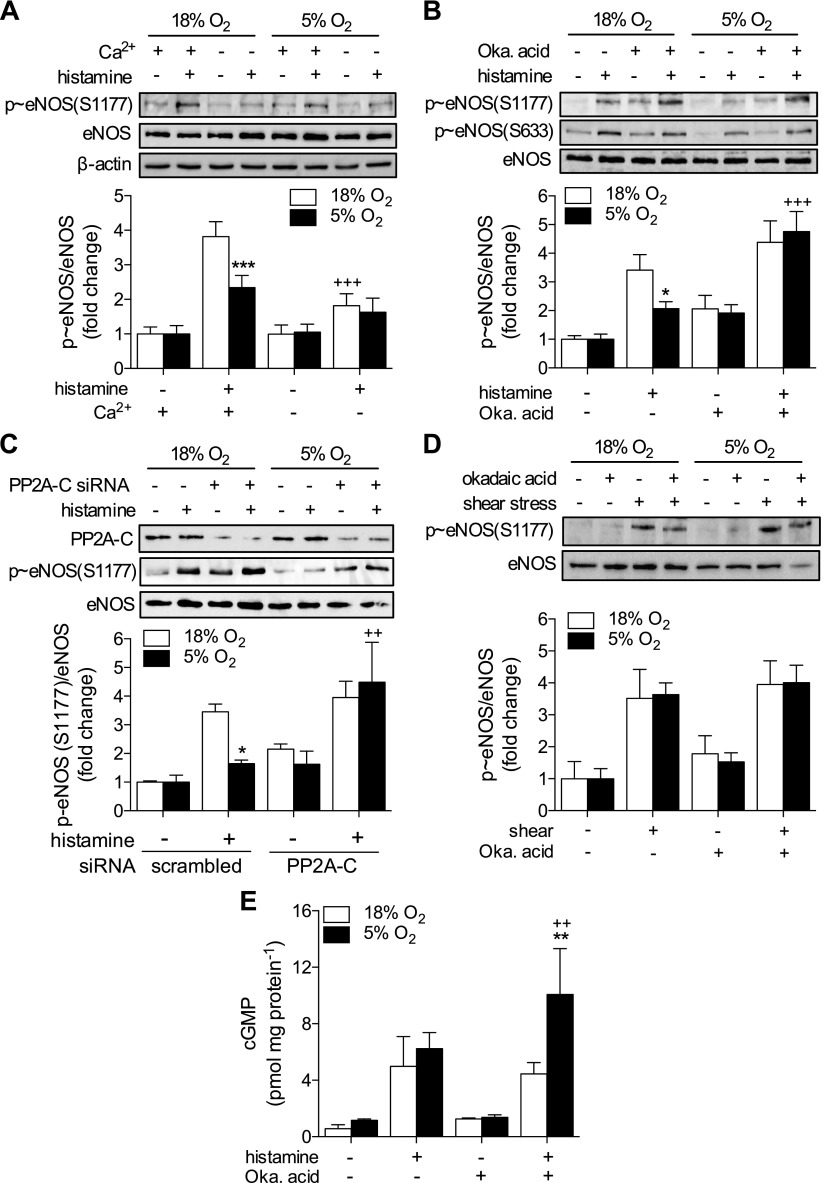
PP2A is responsible for histamine-stimulated eNOS dephosphorylation. HUVECs were maintained at 18% O2 or cultured in 5% O2 for at least 5 d. A) Cells were stimulated with histamine (10 µM, 2 min), with or without external Ca2+, and eNOS-S1177 phosphorylation was assessed. B) HUVECs were pretreated with the PP2A inhibitor okadaic acid (100 nM, 30 min), and phosphorylation of eNOS-S1177/S633 was assessed in response to histamine (10 µM, 5 min). C) HUVECs were transfected with scrambled (−) or PP2A-C siRNA and then stimulated with histamine. D) eNOS phosphorylation at S1177 in HUVECs pretreated with okadaic acid and then subjected to shear stress (15 dyn/cm2, 10 min). E) cGMP production in response to histamine (10 µM, 5 min) after pretreatment with okadaic acid. Representative immunoblots and densitometric analyses for p-eNOS expression relative to total eNOS and a β-actin loading control (data not shown in all panels). Data are expressed as fold change and are means ± sem (n = 4–6 different donors). Treatment with histamine or shear stress was significant (P < 0.05 vs. respective control) in relevant panels. *P < 0.05, **P < 0.01, ***P < 0.001 vs. 18% O2; +P < 0.05, ++P < 0.01, +++P < 0.001 vs. histamine alone/+Ca2+.